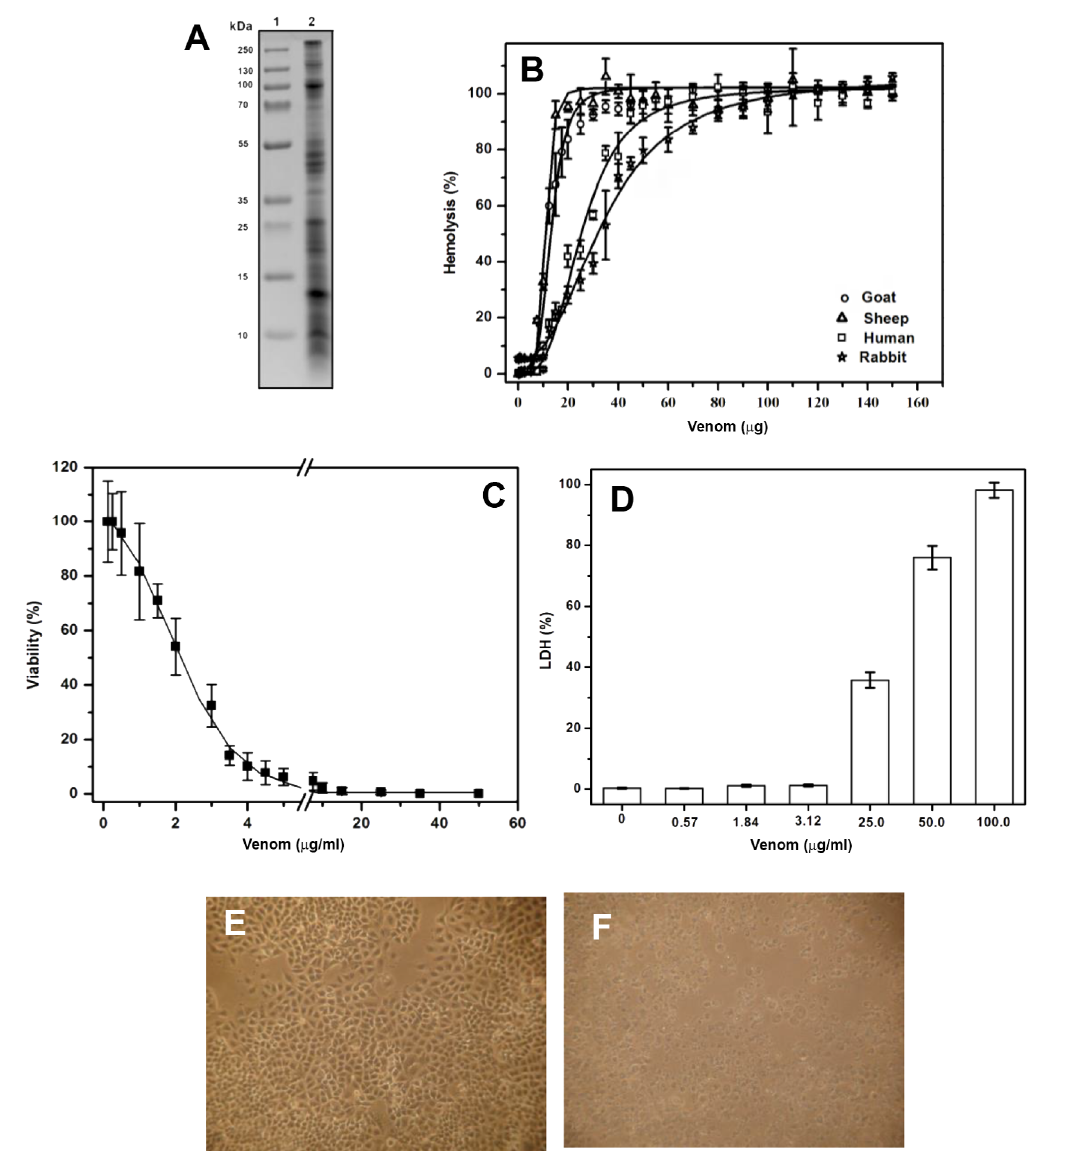
Figure 1 Characterization of A. dowii Verrill (1869) venom. A. SDS-PAGE analysis of venom, lane 1: protein molecular weight marker, lane 2: venom. B. Hemolysis produced by the venom in erythrocytes from different mammals. C . Viability assay of A549 cells exposed to different concentrations of sea anemone venom. D . Cytotoxicity was analyzed by measuring LDH released from A549 cell line. Morphological changes of A549 cells without ( E ) and with ( F ) 50 μg/mL of total protein from venom were observed via transmitted light